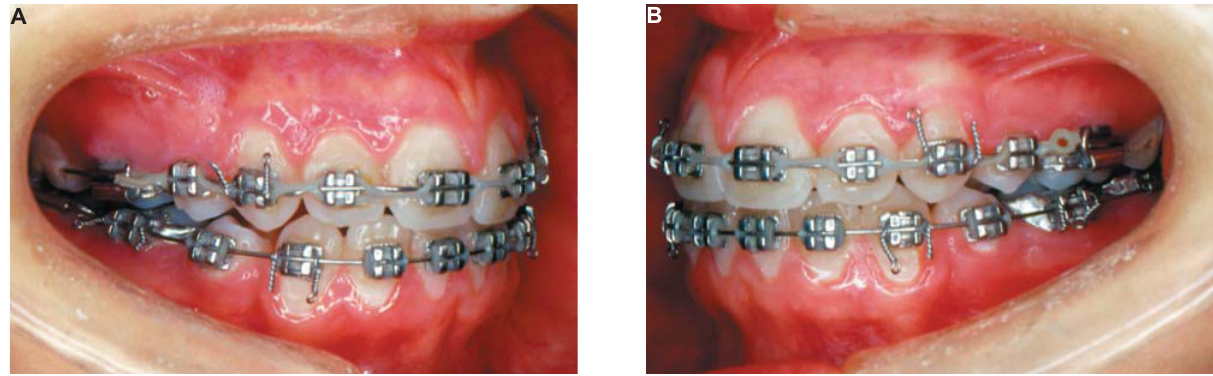
Figure 6- (cid:10)(cid:28)(cid:17)(cid:16)(cid:6)(cid:7)(cid:12)(cid:6)(cid:7)(cid:9)(cid:10)(cid:11)(cid:19)(cid:12)(cid:16)(cid:12)(cid:29)(cid:6)(cid:7)(cid:11)(cid:19)(cid:4)(cid:10)(cid:4)(cid:19)(cid:12)(cid:30)(cid:5)(cid:17)(cid:29)(cid:10)(cid:16)(cid:19)(cid:3)(cid:10)(cid:15)(cid:21)(cid:3)(cid:13)(cid:10)(cid:7)(cid:11)(cid:11)(cid:9)(cid:5)(cid:7)(cid:17)(cid:23)(cid:3)(cid:10)(cid:31)!(cid:10)(cid:7)(cid:17)(cid:13)(cid:10)"#